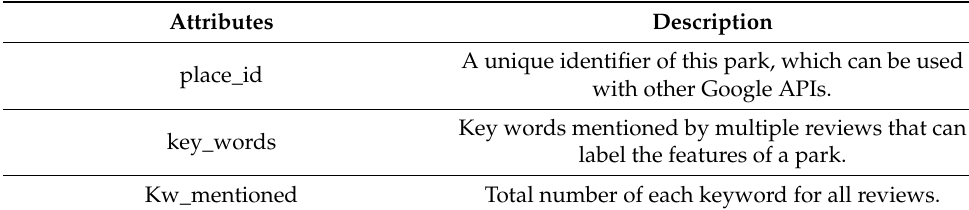
Table 2. Key words from the Google Maps